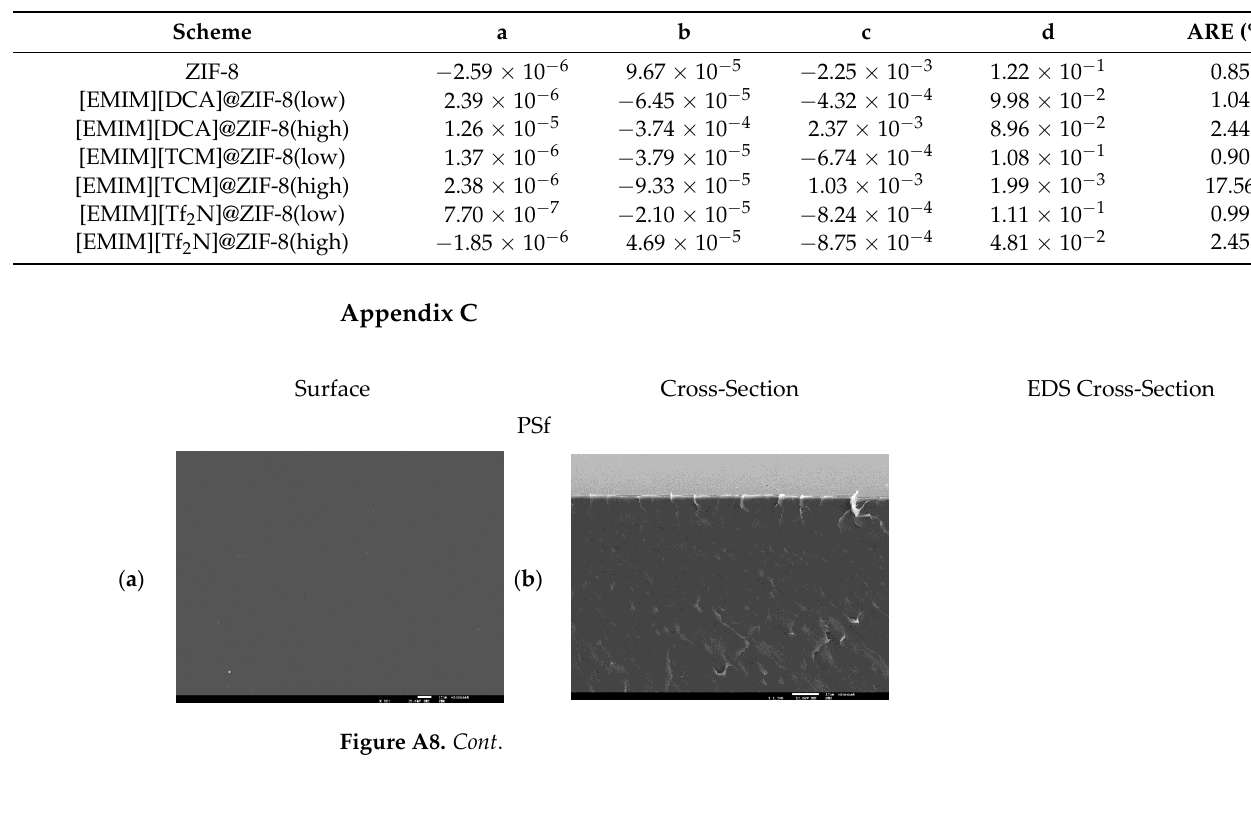
Table A3. CH 4 coefficient parameters and global average relative error of the fitting using Equation (3).